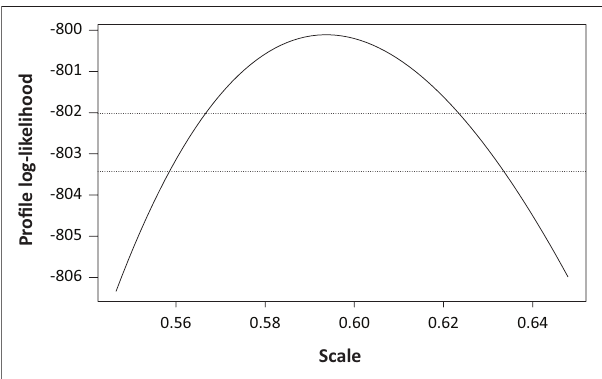
FIGURE 5-A1: Profile log-likelihood for the scale parameter σ using estimates of the model with r = 4.